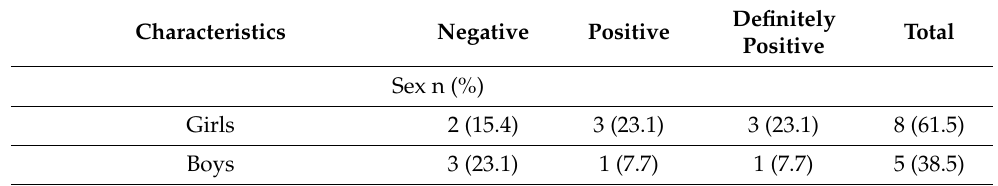
Table 2. Characteristics of the